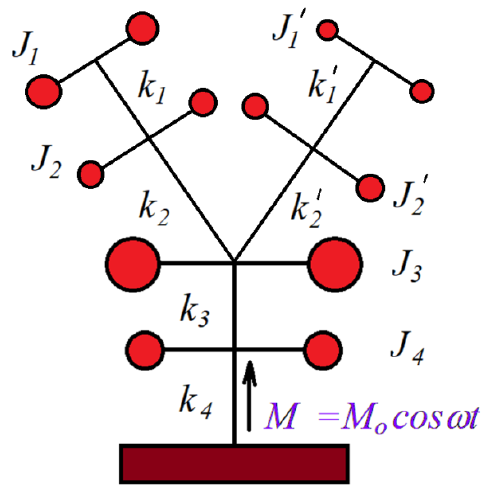
Figure 1. Elastic system with wheels.